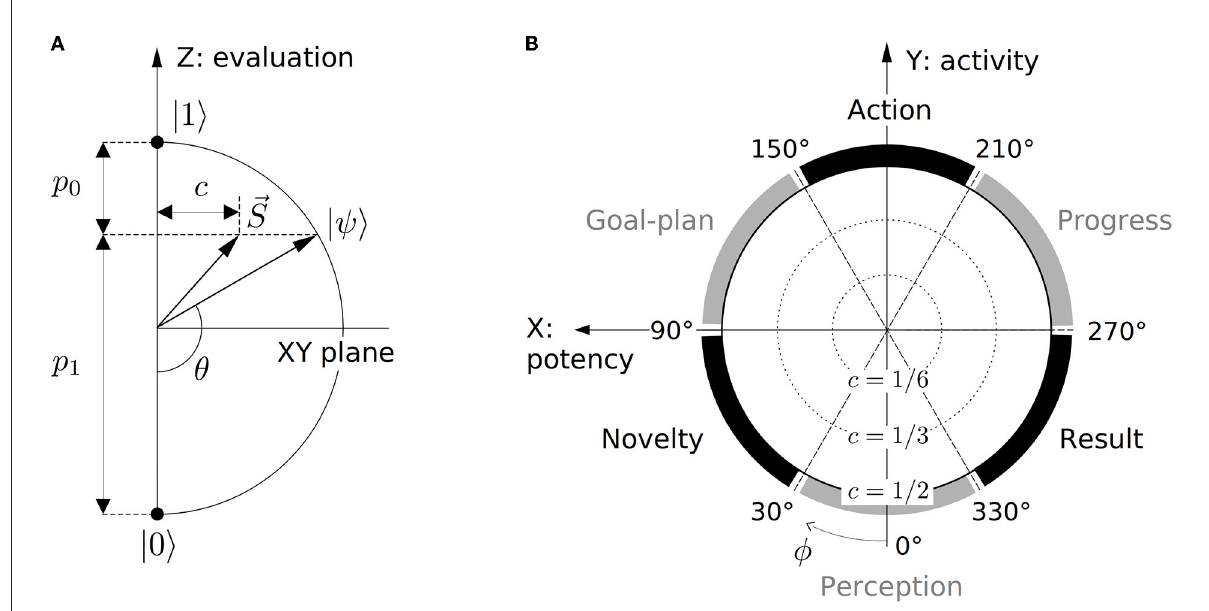
FIGURE2 Dimensions of the qubit space of subjective experience. (A) Vertical section of the Bloch sphere with Z-axis encoding subjective evaluation of contexts. Z-component of both pure (Equation 1) and mixed (Equation 8) state vectors defines observable probabilities p i . Coherence c quantifies control of a subject over the resolution of the basis decision alternative. (B) Horizontal section of the Bloch sphere. Process-semantic classes of contexts Perception, Novelty, Goal-plan, Action, Progress, and Result demarcate the qubit’s azimuthal dimension φ . Pure and mixed states of each class occupy the perimeter and interior of the corresponding azimuthal